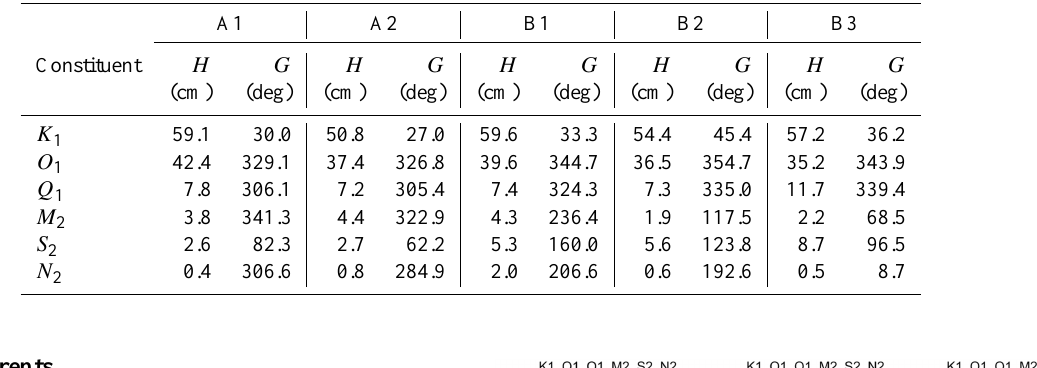
Table 3. Tidal harmonic constants at the observation stations.